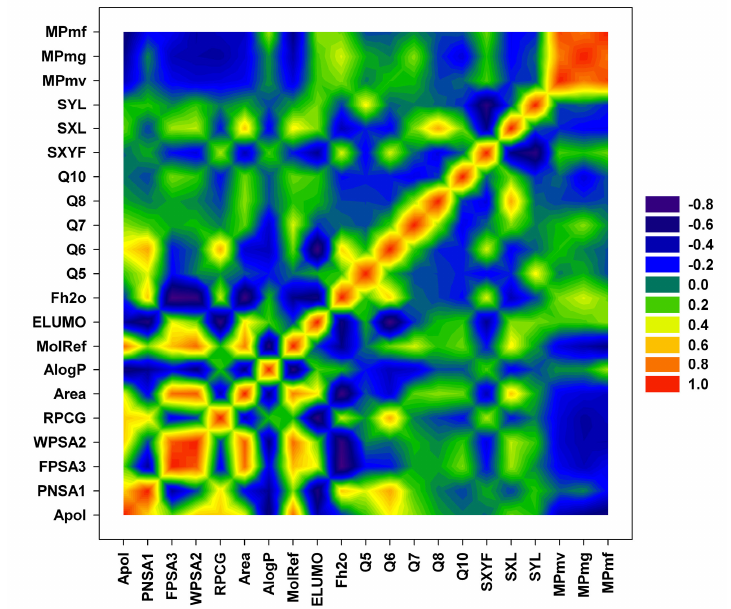
Figure 4. The correlation matrix presentation of QSAR